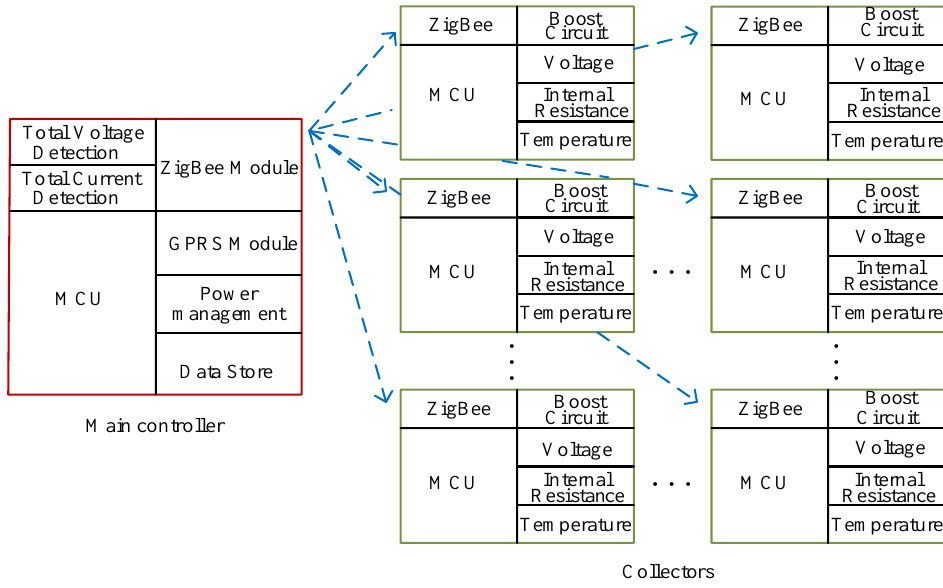
Figure 2. Functions and communication between the main controller and collectors.